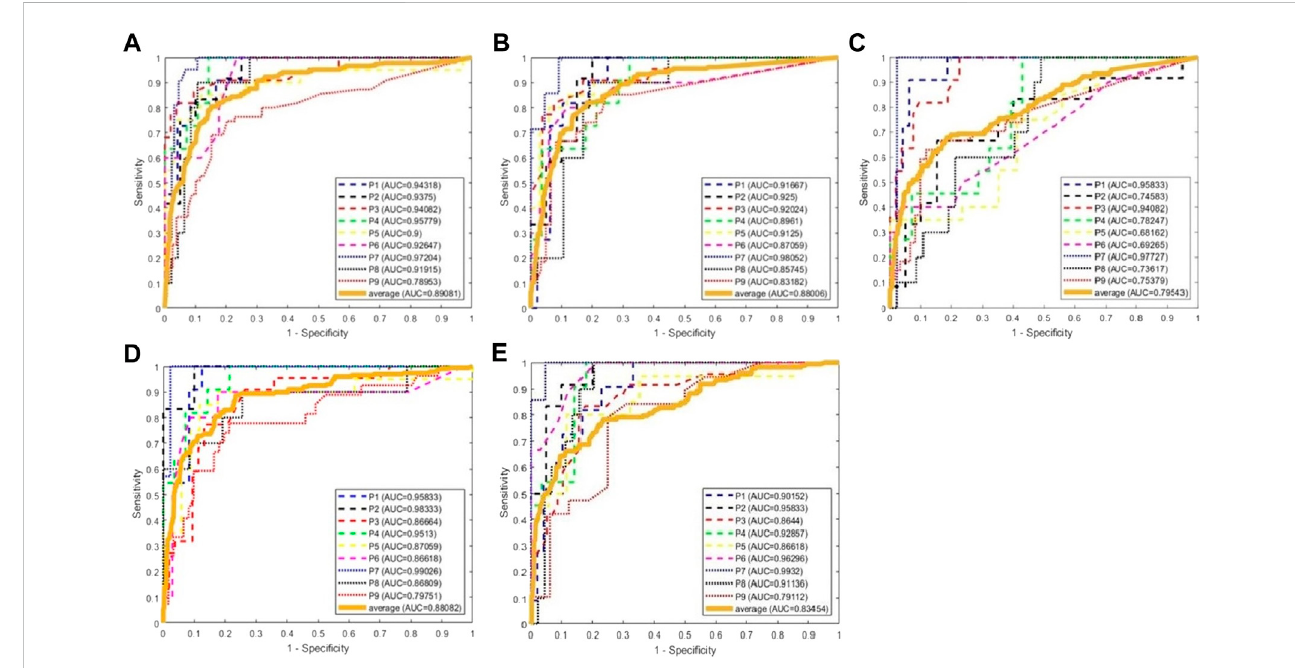
FIGURE 5 ROC curves ofclassi fi cation usingCNN, SVM, randomforest, andCV-CNN. (A) ROC curvesusing CNN. (B) ROCcurvesusingSVM. (C) ROC curvesusing random forest. (D) ROC curves using CNN and PAC. (E) ROC curves using CV-CNN and ST-CV-PAC.